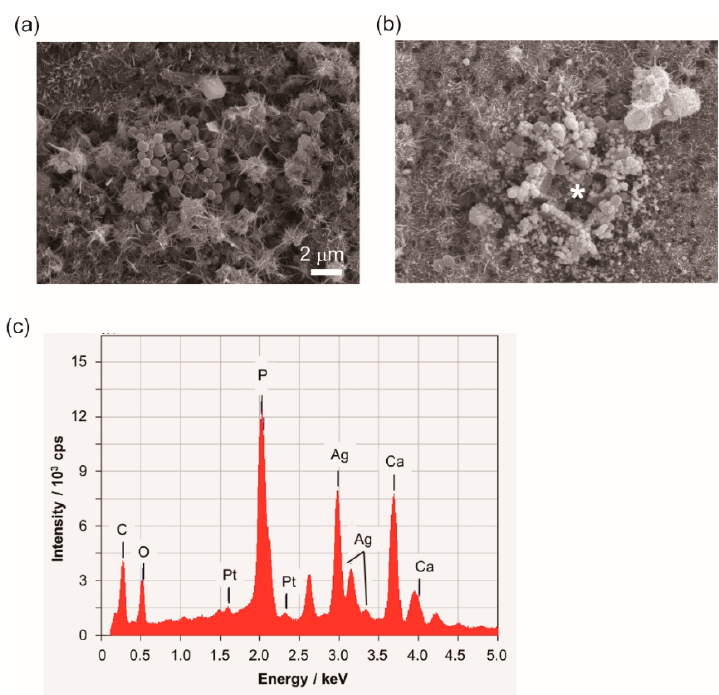
Figure 9. SEM observation of microstructure of cement and morphology of bacteria. Bacterial adherence to the surface of Ag-TCP(0) cement ( a ) and Ag-TCP(5) cement ( b ) at 24 h after culture. Energy dispersive X-ray spectrometry (EDX) spectrum of Ag-TCP(5) cement shows the asterisk in Figure 9b ( c ). Scale bar indicates 2 μ m.